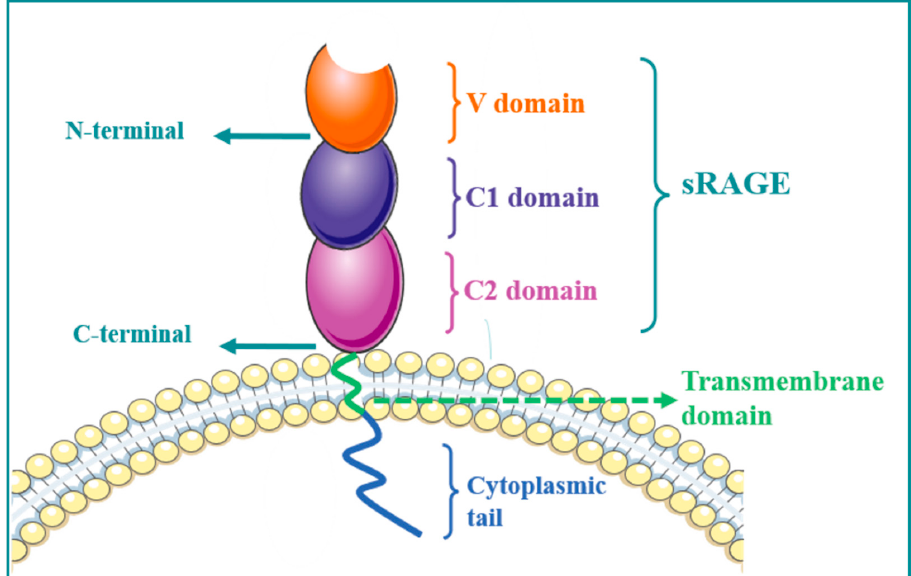
Figure 1. RAGE structural organization. The extracellular domain comprises three domains: V, C1, and C2. One transmembrane receptor passes through the plasma membrane bilayer, followed by an intracellular cytoplasmic tail. The extracellular region without a transmembrane receptor and a cytoplasmic tail is called soluble RAGE (sRAGE).